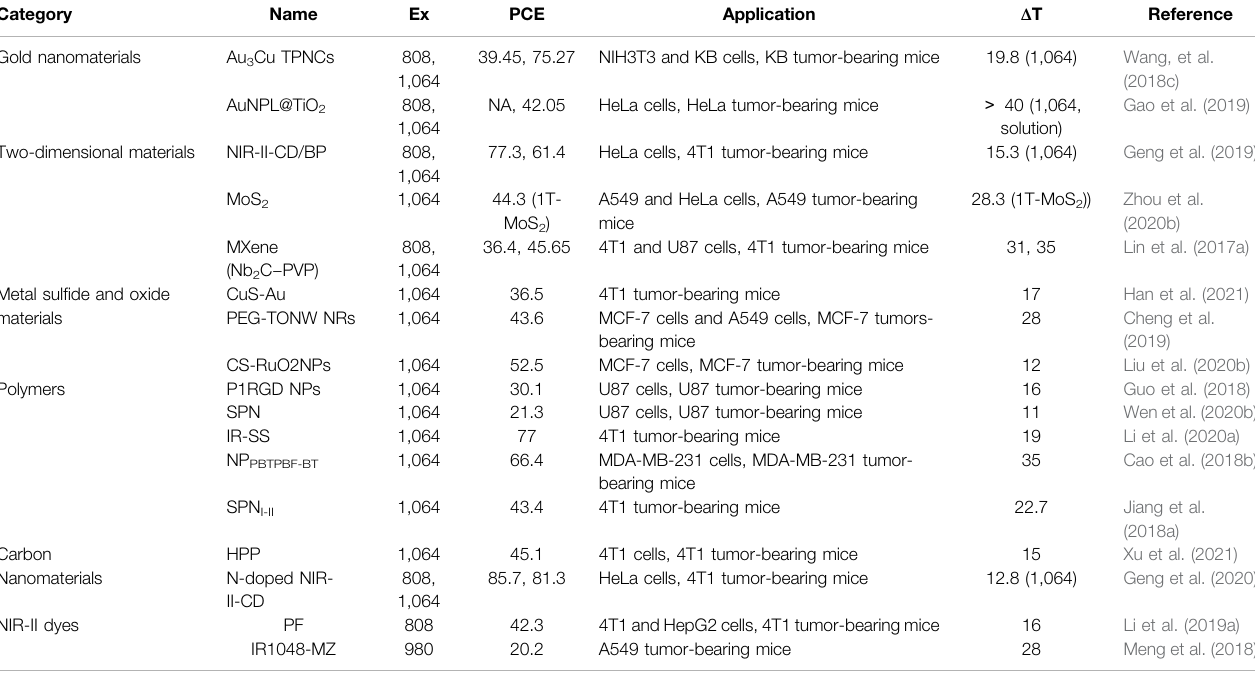
TABLE 1 | Summary of the properties and applications of representative NIR- Ⅱ PTT materials discussed in this review (Ex, excitation wavelength (nm); PCE, photothermal conversion ef fi ciency (%); Δ T, temperature increased ( ° C); NA, not applicable).